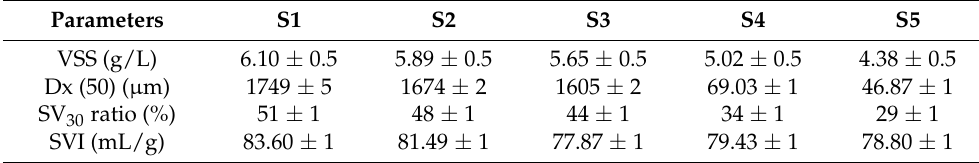
Table 3. Solid-phase changes of excess sludge after